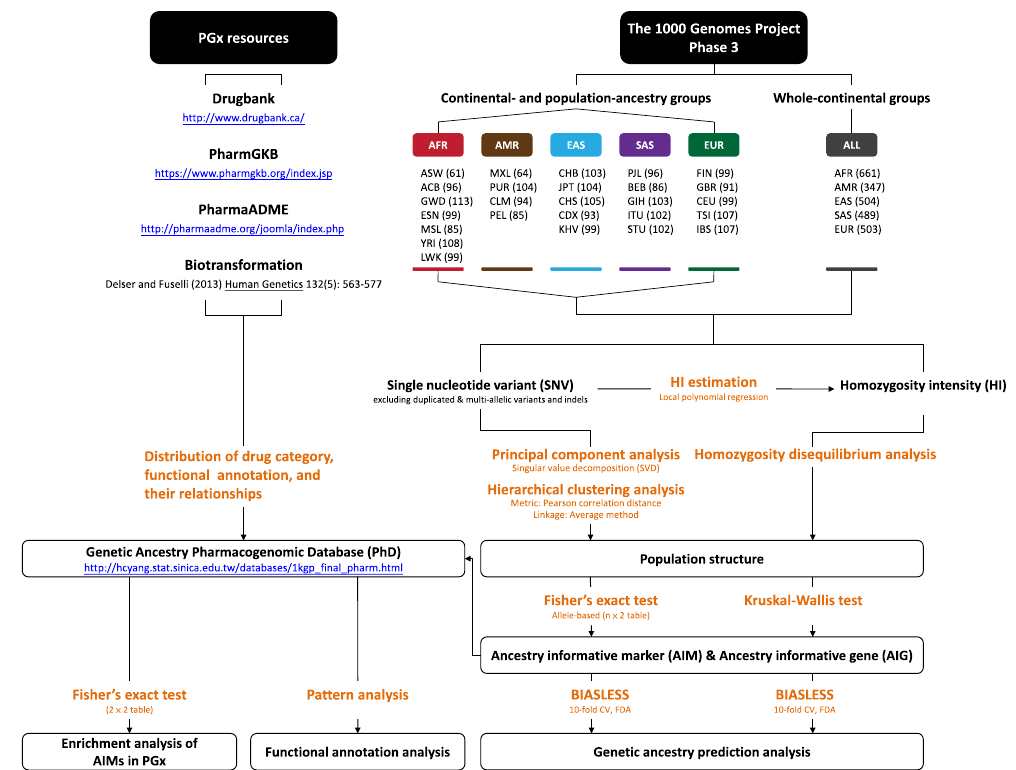
Fig. 3 Analysis fl ow of this study. Genomic structures of 26 populations in fi ve continents were explored using principal component analysis, hierarchical clustering analysis, and homozygosity disequilibrium analysis. Within each of the six study ancestry groups (whole-continents, AFR, AMR, EAS, EUR, and SAS), AIMs were identi fi ed based on each of four genetic variation categories using two-sided Fisher exact tests. Ancestry-informative PGx were identi fi ed and an enrichment of AIMs in PGx loci was evaluated using one-sided Fisher exact tests. Finally, a genetic ancestry PGx database was